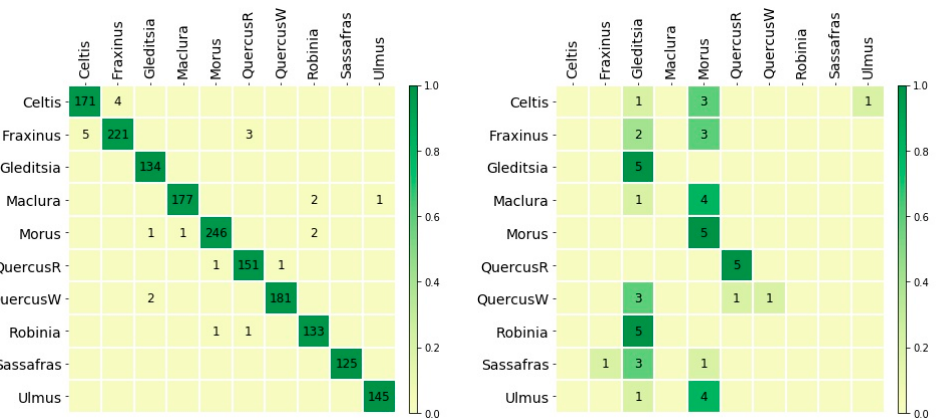
of LD5 was 98.5% (prediction confusion matrix in Figure 4, (left)), while the accuracy of the InceptionV4_ResNetV2 model reported in [37] was 92.6%. The lack of specimen level information for LD-train precluded the computation of specimen level metrics. LDF had a specimen level accuracy of 32.0% when tested on LD-test and the corresponding predic- tion confusion matrix is shown in Figure 4 (right).